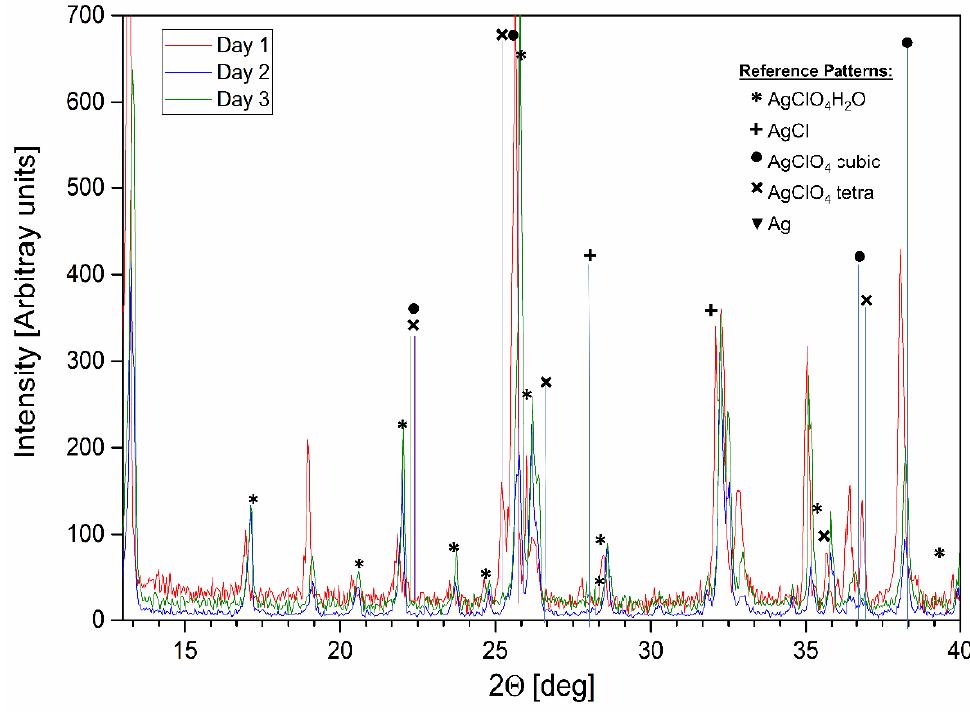
Figure 11. The powder X-ray diffractograms of the change of the composition of I-240 . There are important differences in the shape of the perchlorate ν as (ClO) bands, and band positions belong to the coordination-sensitive ammonia modes ( δ (NH) and ρ (NH)) in the IR spectra of I-240 and compound 1 (Figure 12). Aqueous extraction of I-240 and the evaporation of the solution resulted in silver perchlorate monohydrate and an unknown phase. The IR (Figure 12) spectrum showed an important shift (60 cm − 1 ) of peak positions and the shape of ν as (Cl–O). The δ s (NH) and ρ (NH) bands can be assigned to a more strongly coordinated NH 3 ligand, as in compound 1 (shifting the δ (NH) towards the higher wavenumber range [30]). The unknown phase may be a silver salt of a chlorine oxyacid, which contains fewer than 2 ammonia per silver (e.g., a polymeric monoammine). This intermediate can decompose into the same compounds (N 2 , H 2 O, AgCl, AgClO 4 ) as compound 1 . We attributed the change in the shape of the antisymmetric Cl–O IR band to the presence of two different chlorine oxyacid compounds in the intermediate I-240. One is a perchlorate, the other is a chlorate compound. For the chlorate component, the ν as (Cl–O) bands (AgClO 3 ( ν as (ClO) = 987,967) (Figure 12)) are expected to appear in the lower wavenumber range of the wide perchlorate ν as (ClO) band. The presence of diamminesilver(I) chlorate cannot be expected because it melts and decomposes at 100 ◦ C with the formation of AgClO 3 [31].